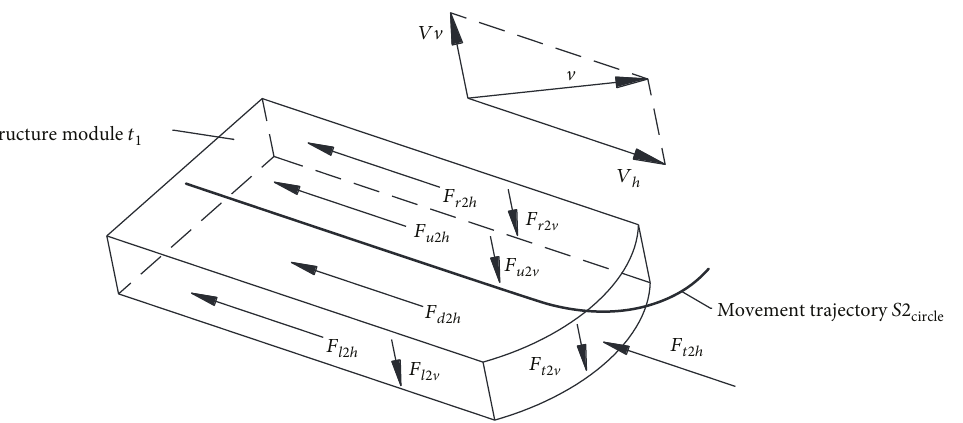
S 2 1 in stage circle .